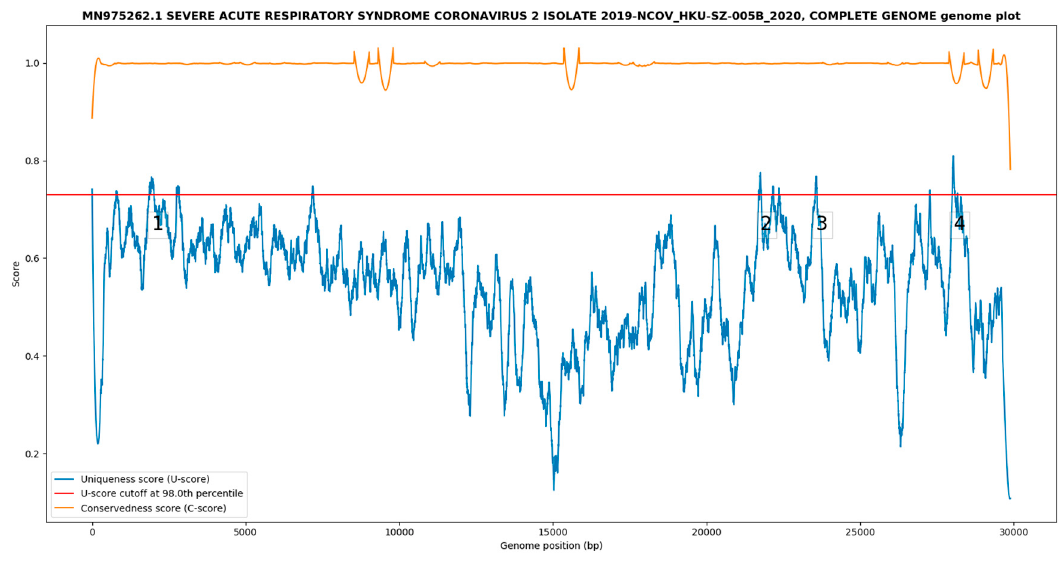
Figure 1. Genome uniqueness / conservedness plot generated by GolayMetaMiner. The orange curve denotes the Savitzky–Golay smoothed conservedness score (C-score), and the blue curve and red line denote the similarly smoothed uniqueness score (U-score) with the corresponding cuto ff in the 98th percentile cuto ff score. Areas of the blue curve above the cuto ff represent the severe acute respiratory syndrome coronavirus 2 (SARS-CoV-2) unique targets, potentially. The genomic targets ( > 50 nt) identified were marked by the numbers 1, 2, 3 and 4 in the figure as part of the program output. Table 1. SARS-CoV-2 specific targets ( > 50 nt) reported by GolayMetaMiner .